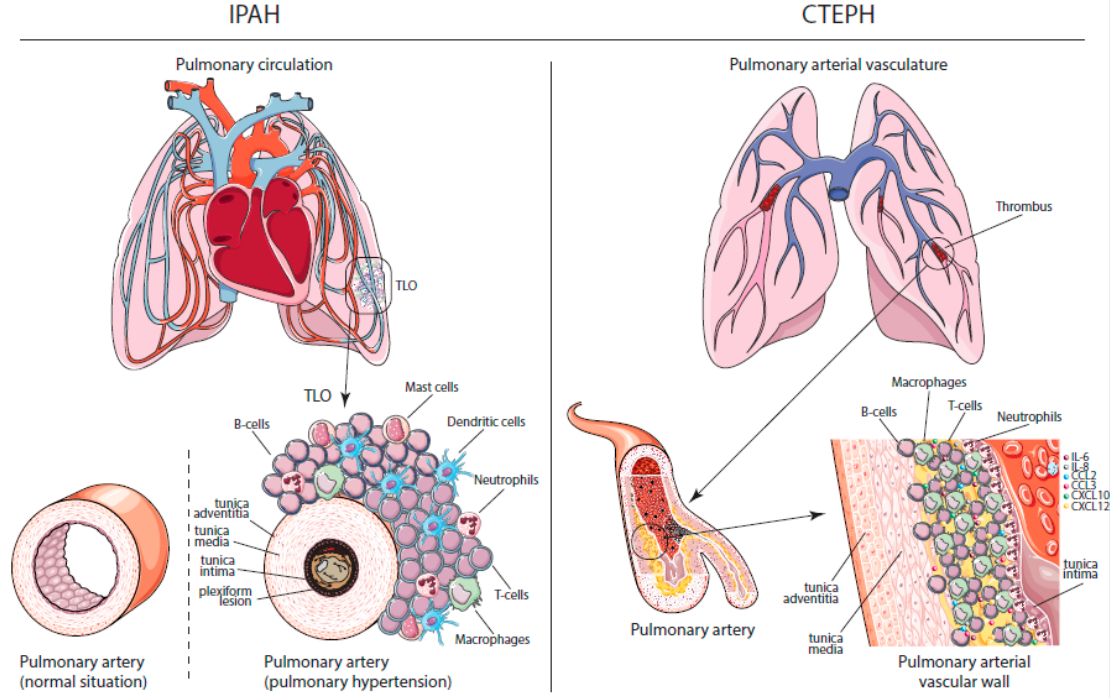
Figure 1. Immunohistopathology in IPAH and CTEPH. Left: schematic overview of cells involved in tertiary lymphoid organs (TLOs) in idiopathic pulmonary arterial hypertension (IPAH) patients. In the pulmonary hypertension (PH) situation, endothelial hyperproliferation is visible in the tunica intima with plexiform lesion formation in the lumen of the artery. Furthermore, smooth muscle cell (SMC) hyperplasia is visible in the tunica media of the pulmonary artery. Surrounding the tunica adventitia is a combination of B cells, T cells, mast cells, dendritic cells, neutrophils and macrophages. Right: schematic overview of vascular remodeling and inflammation in the thrombotic material of chronic thromboembolic pulmonary hypertension (CTEPH) patients. Between the (neo)intimal vascular wall and the tunica media, an influx of inflammatory cells such as B cells, T cells, neutrophils and macrophages is visible. Moreover, the enhanced presence of pro-inflammatory mediators, such as interleukin (IL)-6, IL-8, chemokine (C-C motif) ligands 2 and 3 (CCL2 and CCL3), C-X-C motif chemokines 10 and 12 (CXCL10 and CXCL12) is present.